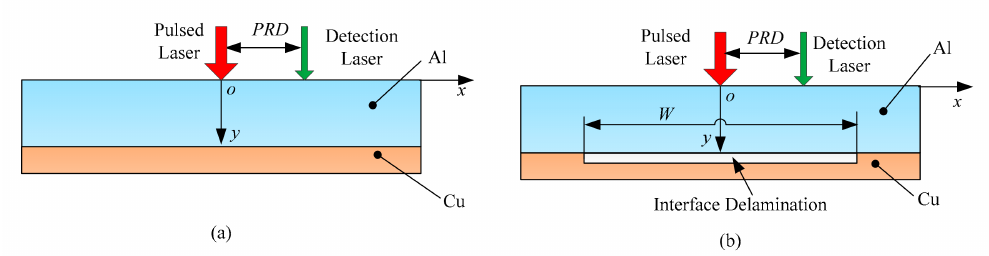
Figure 1. Laser ultrasound in copper-aluminum composites: ( a ) a model without defects; ( b ) a model with delamination. Table 1. The thermo-physical parameters of Cu and Al used in the finite element (FE) models. Physical